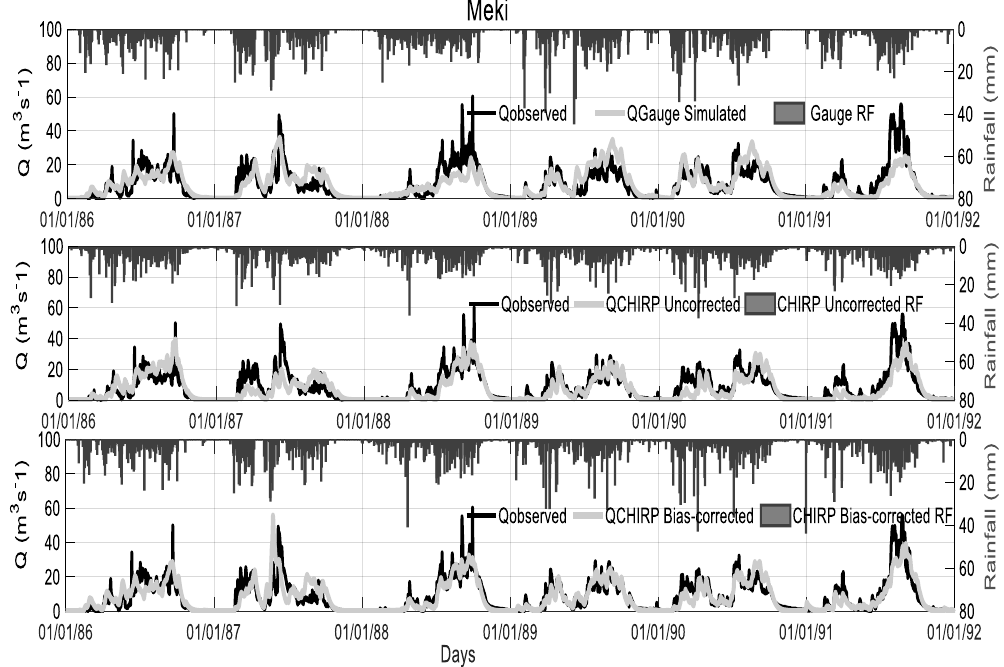
Figure 7. Model calibration result of Meki catchment (1986–1991) from gauge, uncorrected, and bias-corrected CHIRP satellite rainfall input.